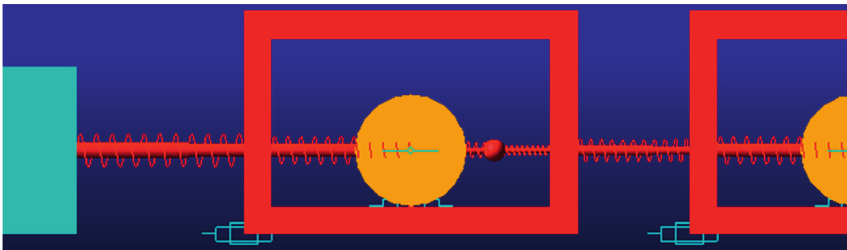
Figure 9: A schematic of a unite cell of 2DOF model-MSC-ADAMS